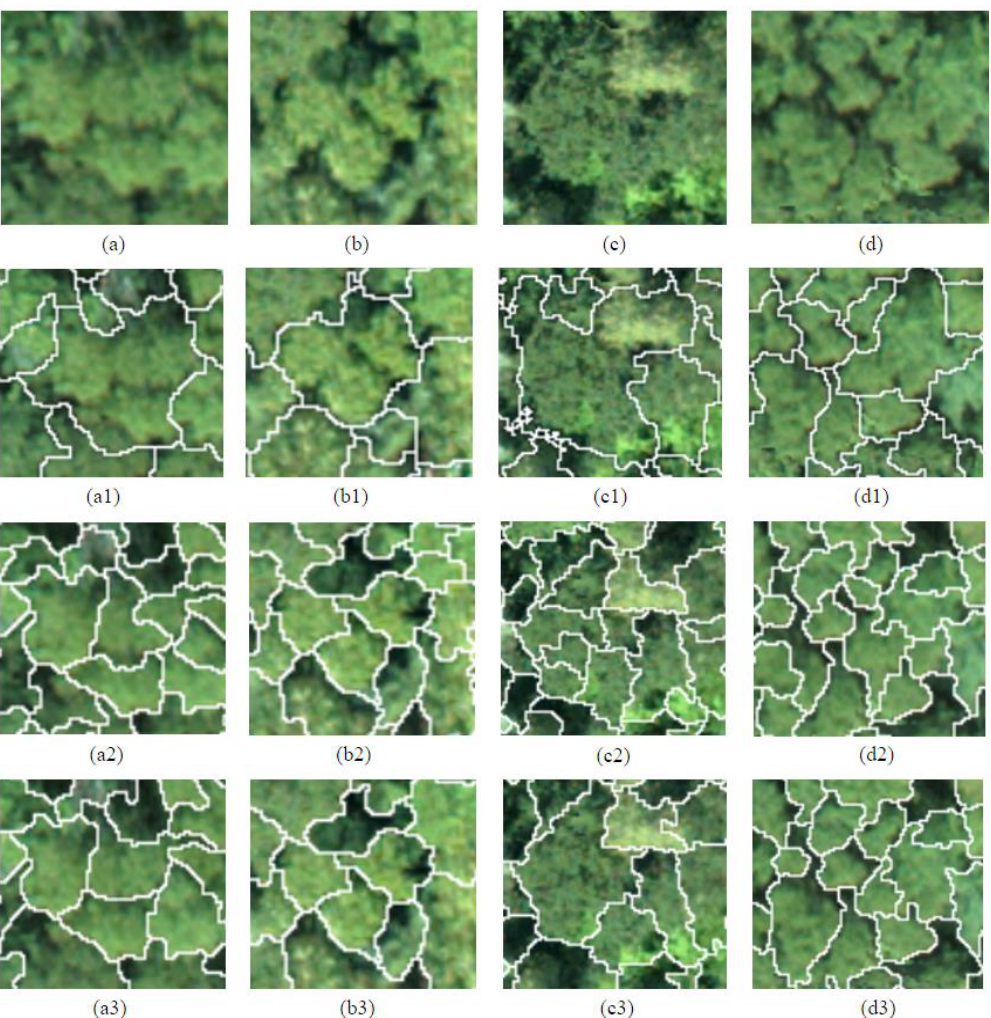
Figure 13. Subsets of the deciduous forest plot ( a – d ) and the subsets of the tree crown maps obtained by the Crown Slices from Imagery (CSI) ( a1 – d1 ), the commonly used marker-controlled watershed segmentation (MWT) ( a2 – d2 ), and the proposed (SMS) ( a3 – d3 ) methods.